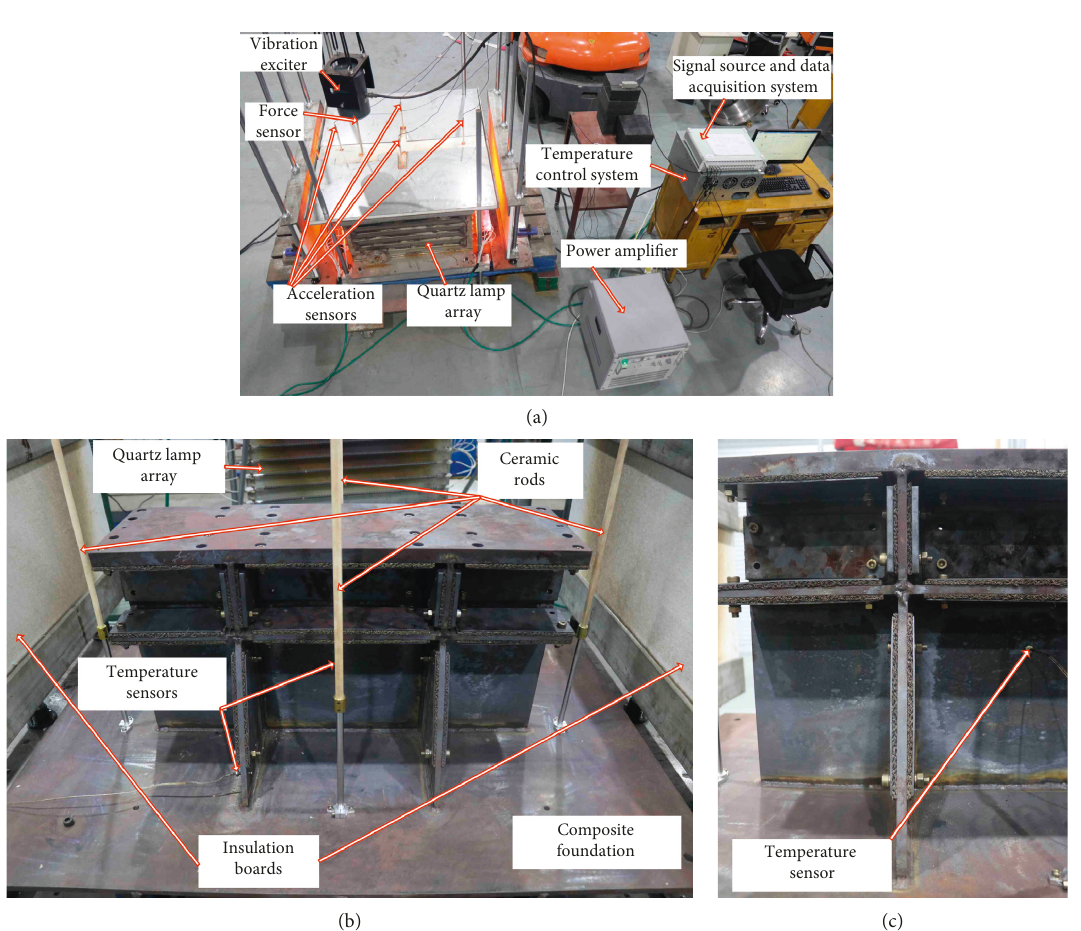
Figure 18: The thermal-vibration joint test system for foundation. (a) Test arrangement. (b) Composite foundation and temperature measuring point. (c) Temperature sensor.